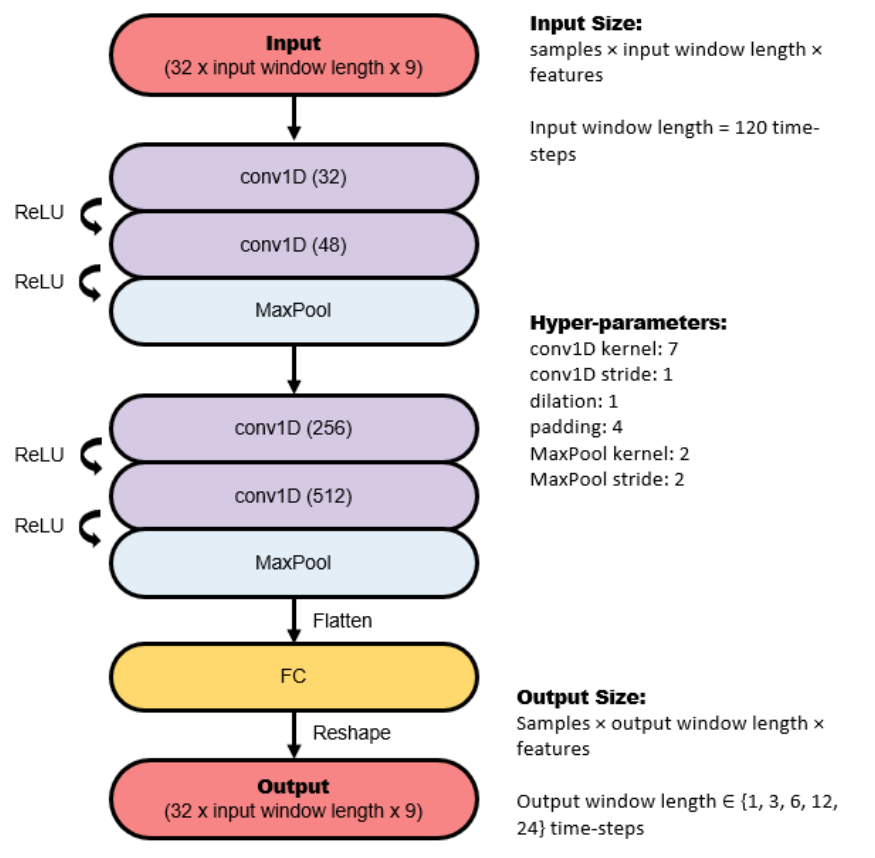
Figure 3. Architecture of the convolutional neural network used in this